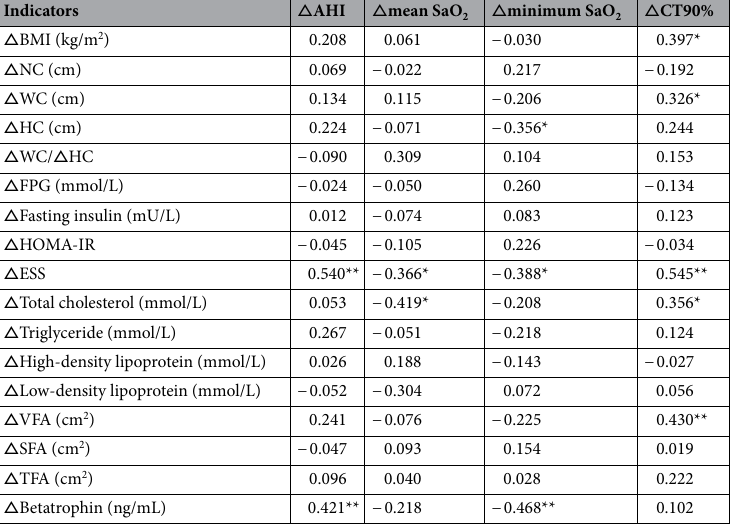
Table 3. Factors associated with the alleviation of OSA. OSA obstructive sleep apnea, AHI apnea hypopnea index,